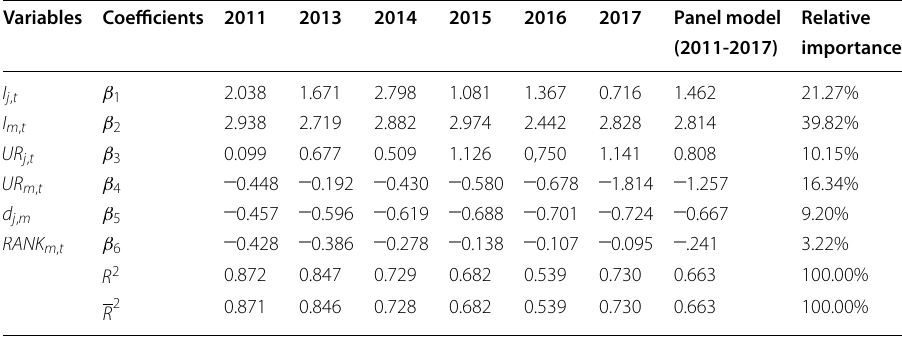
Table 6 Results of the gravity model for all first‑place applications to higher education institutions